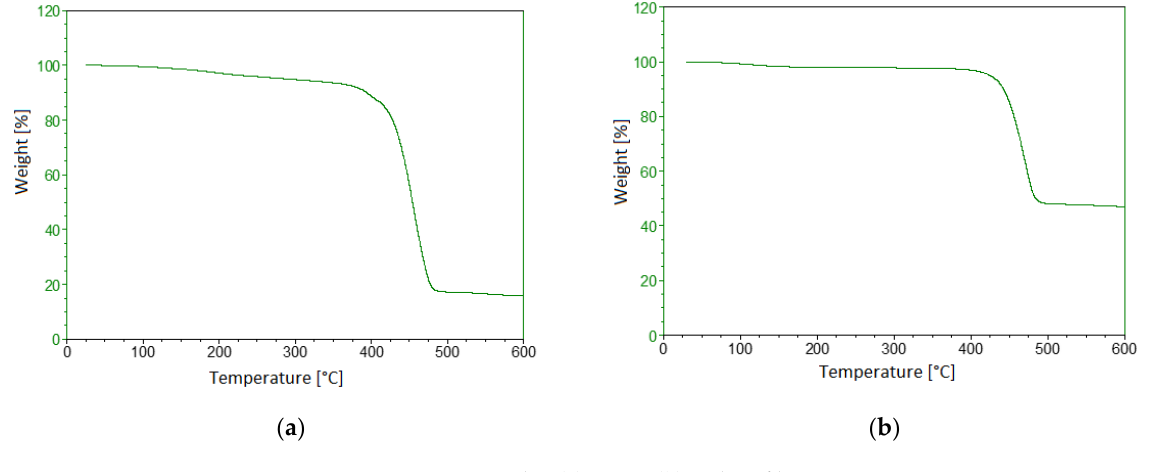
Figure 4. TGA results. ( a ) Onyx; ( b ) carbon fibre.